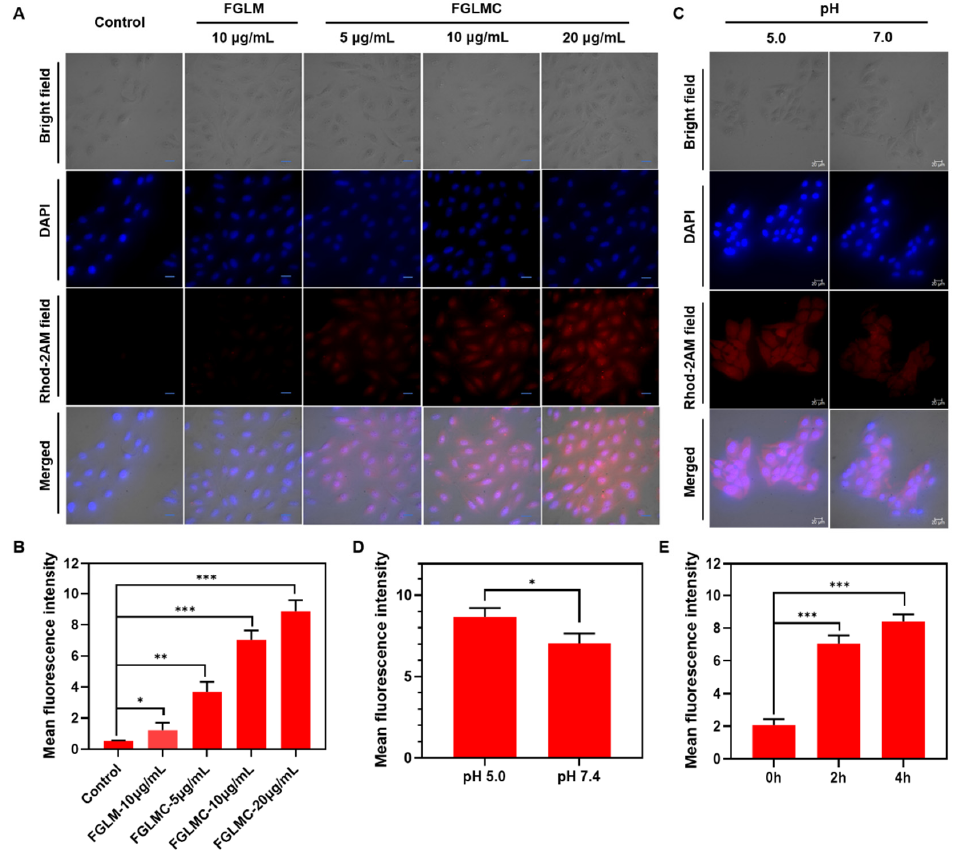
Figure 2. Calcium release of ( A ) FGLM and FGLMC with different concentrations and ( B ) semi- quantitative analysis (Scale bars represent 20 µ m, * p < 0.05, ** p < 0.005, *** p < 0.0005). ( C ) Calcium release of FGLMC under different pH conditions and ( D ) semi-quantitative analysis (Scale bars represent 20 μ m, * p < 0.05). ( E ) Fluorescence semi-quantitative analysis of Ca 2+ release with different incubation times (Scale bars represent 20 μ m, *** p < 0.0005). Each value represents means ± SD ( n = 3).